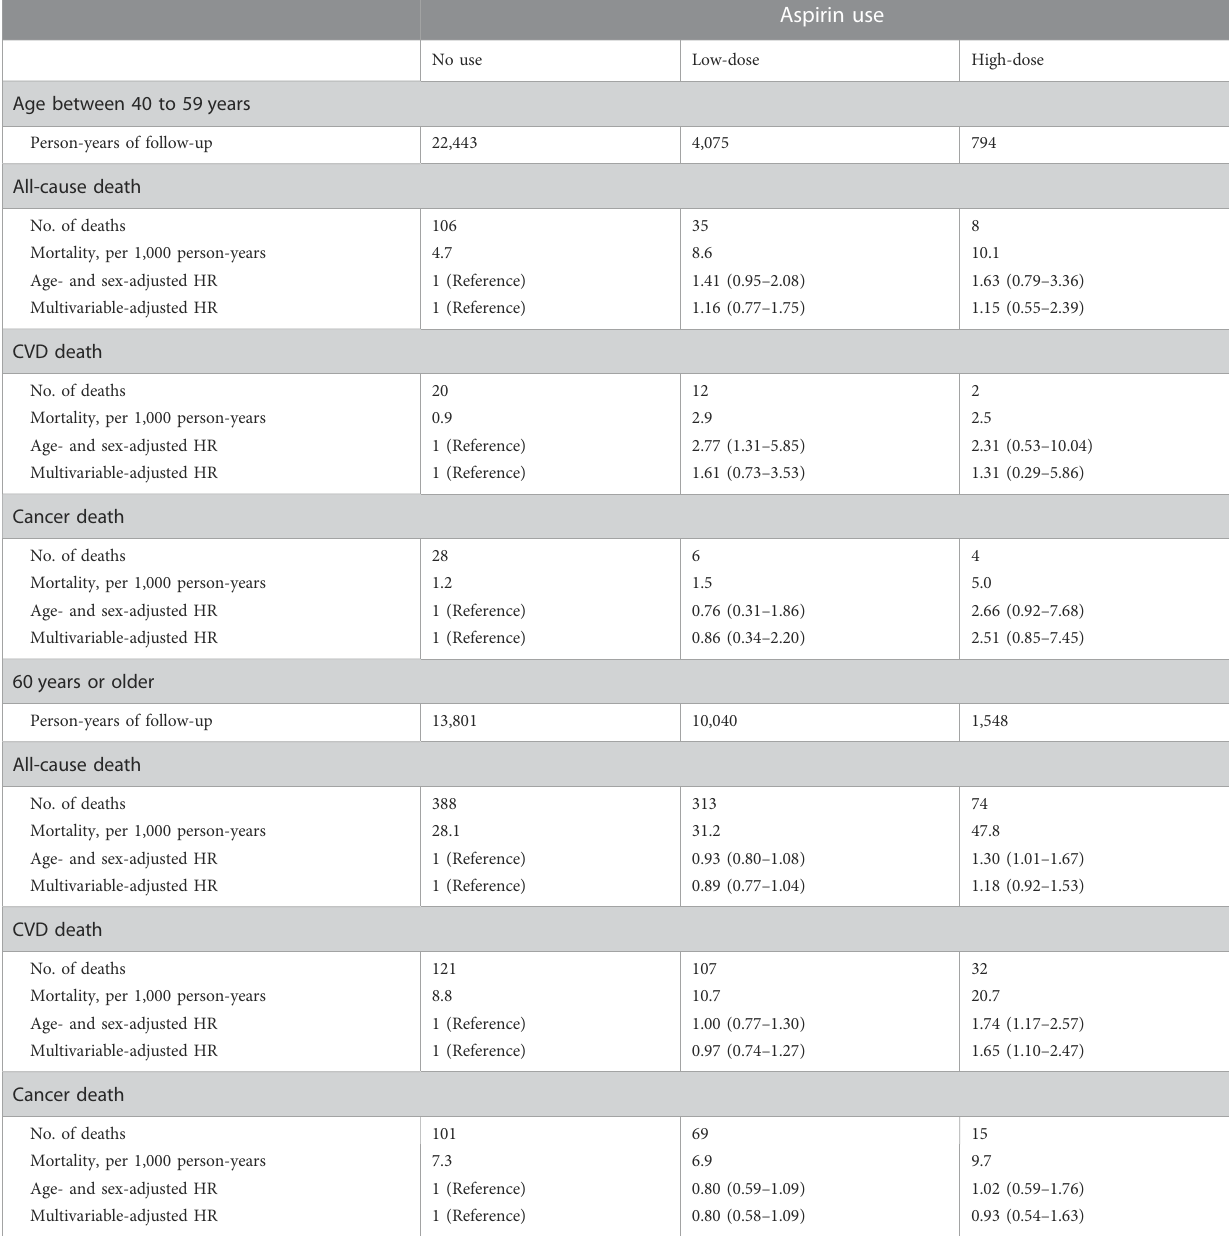
TABLE 3 Strati fi ed analysis for the association between aspirin use and risk of death by